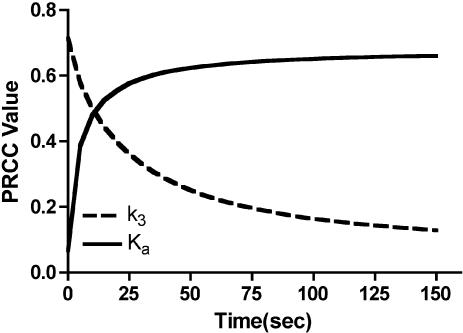
Example of the Time Course of PRCC ValuesTime course of PRCC values for LR association rate constant (k3) and LR equilibrium association constant (Ka) correlated to %OverBasal (as given by Equation 1) when [L] = 1 nM.